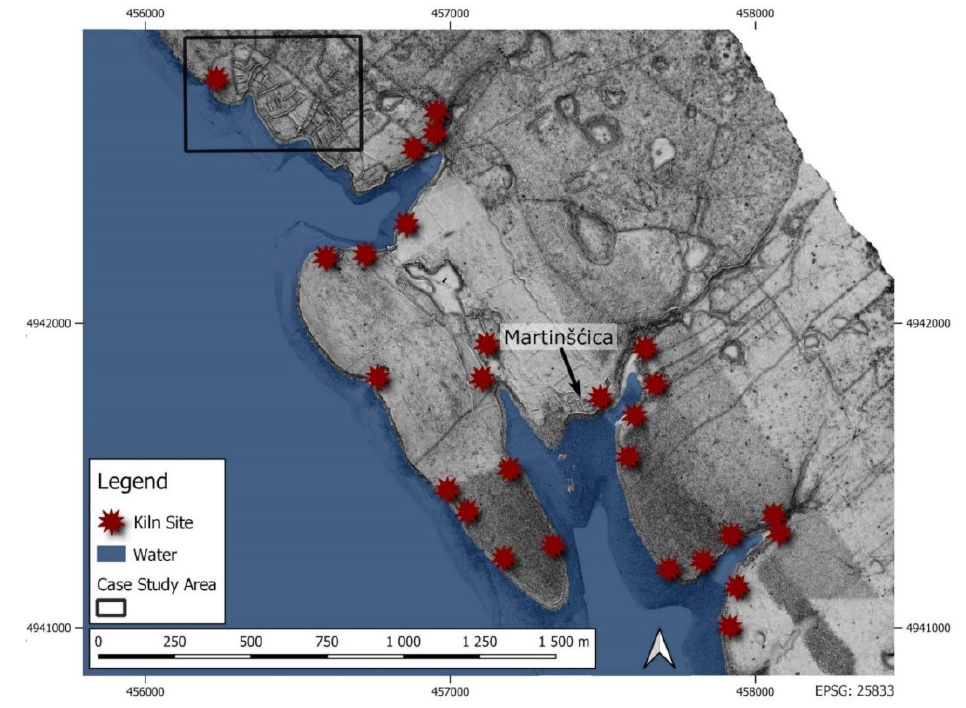
Figure 33. Distribution of lime kilns around the archaeological site of Martinš´cica. The western most symbol marks the site of our case study area, which is outlined in black (visualization: